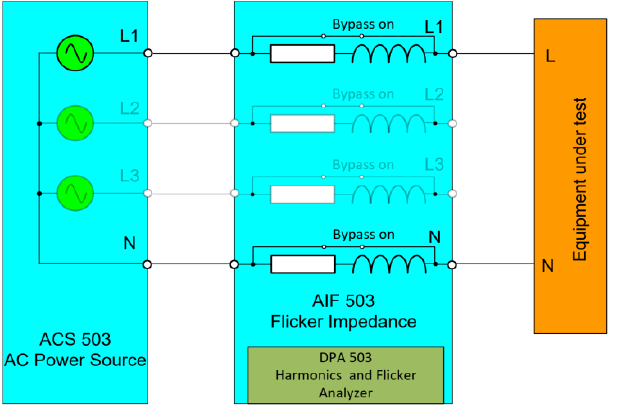
Figure 4. Test setup for the measurement of the harmonic current emission of the EV charging station.